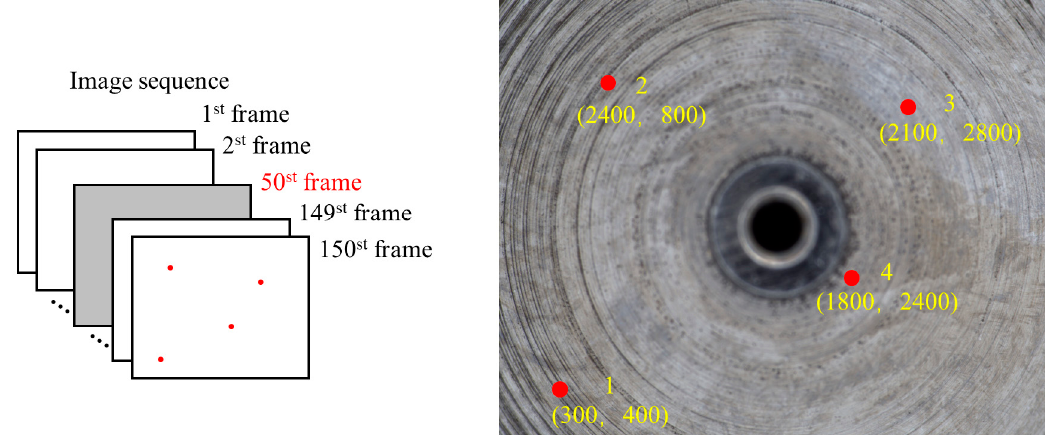
Figure 15. Position of image points 1–4.